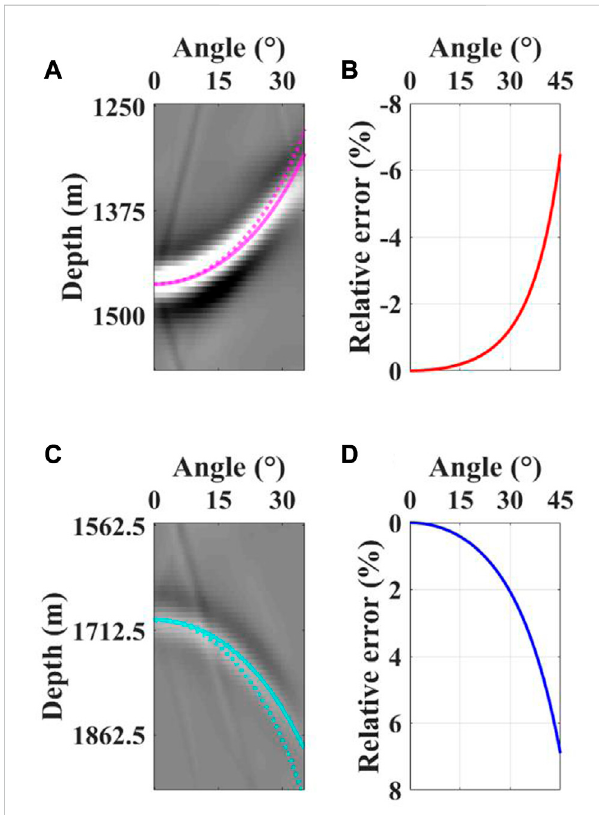
FIGURE 9 Comparison of the tangent-squared approximation equation andtwoRMOequationsintheangledomain. (A) and (C) arethecurves corresponding to the tangent-squared approximation equation and RMO equation for anti-causal and causal crosstalk in angle gathers, respectively. (B,D) are the relative error of the tangent- squared approximation to the more accurate RMO equation for anti- causal and causal crosstalk, respectively. The solid pink line and the pinkdashed line represent theresultsof thederivedRMO equation for anti-causal crosstalk and the tangent-squared approximation equation in angle gathers. The light blue solid line and the light blue dashed line represent the results of the derived RMO equation for causal crosstalk and the tangent-squared approximation equation in angle